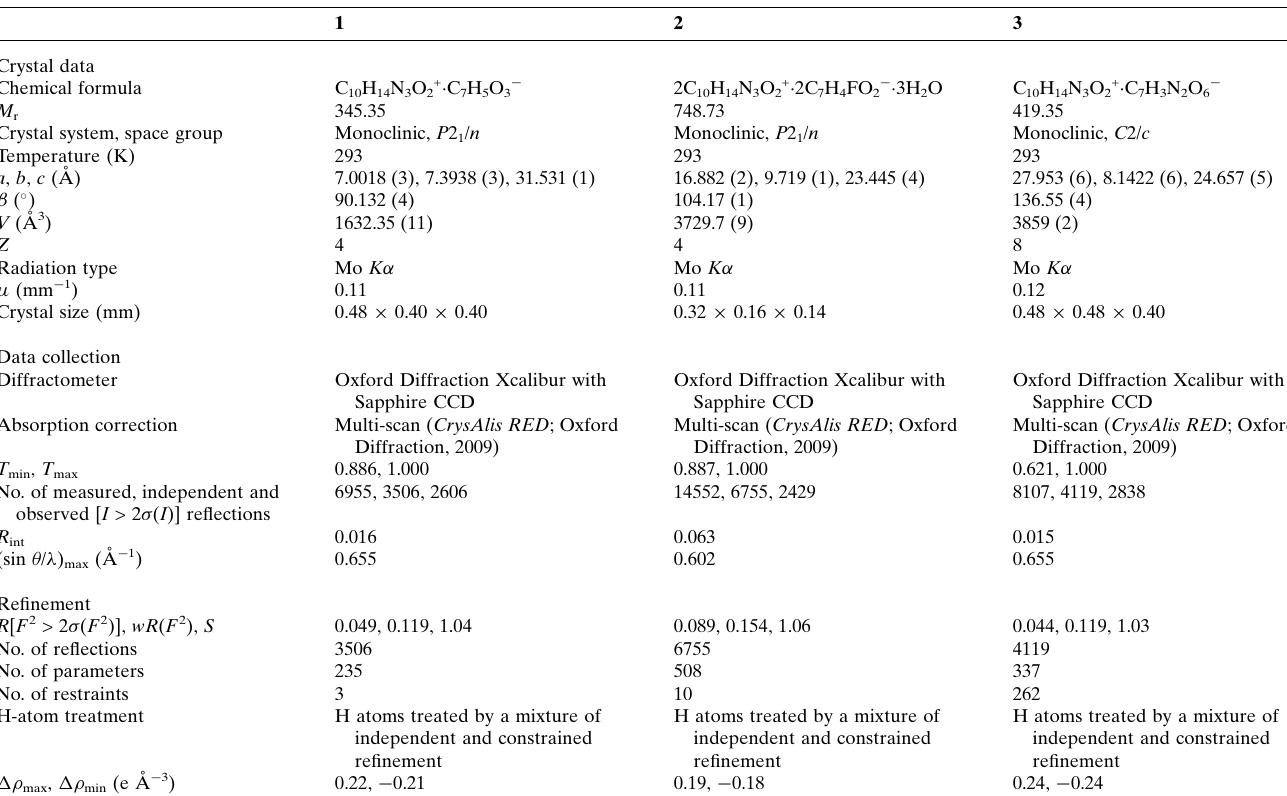
Table 4 Experimental details.